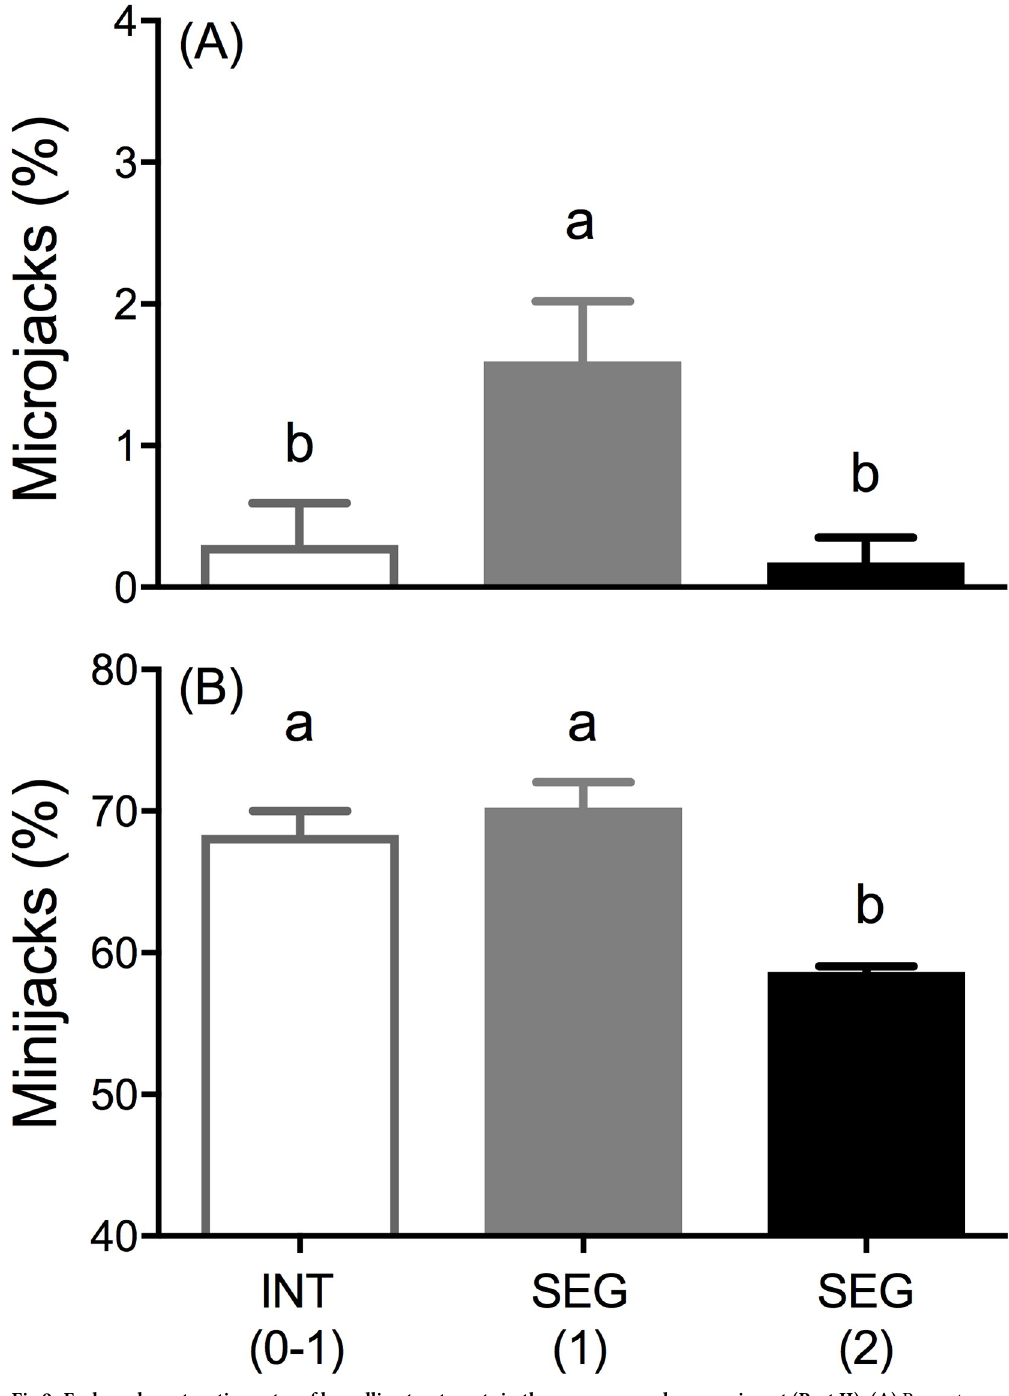
Fig 9. Early male maturation rates of broodline treatments in the common garden experiment (Part II). (A) Percent age- 1 microjacks among males. (B) Percent age-2 minijacks among males. Tanks are replicates ( N ranged from 3 to 4 per treatment). Different letters within panel represent significant differences between broodline treatment using beta regression analyses, α = 0.05. Error bars = SEM.